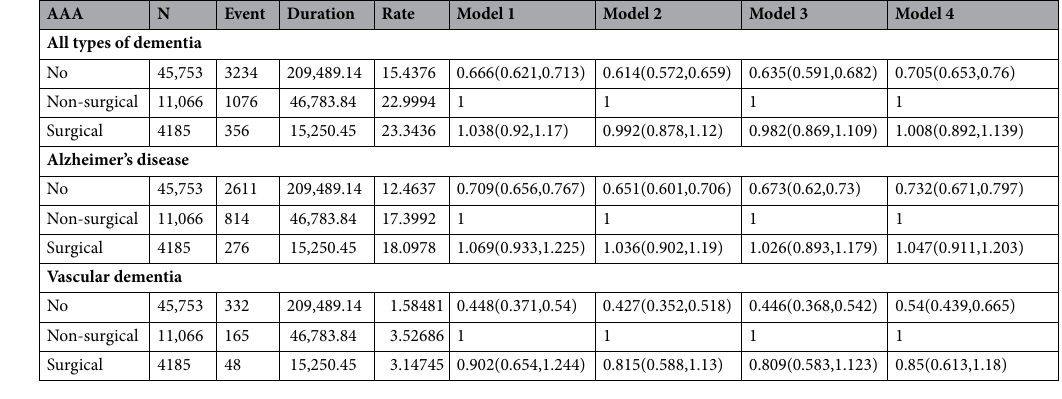
Table 3. Hazard ratio of AAA for incidence of dementia. AAA Abdominal aortic aneurysm, AAA group divided into surgical and non-surgical groups.